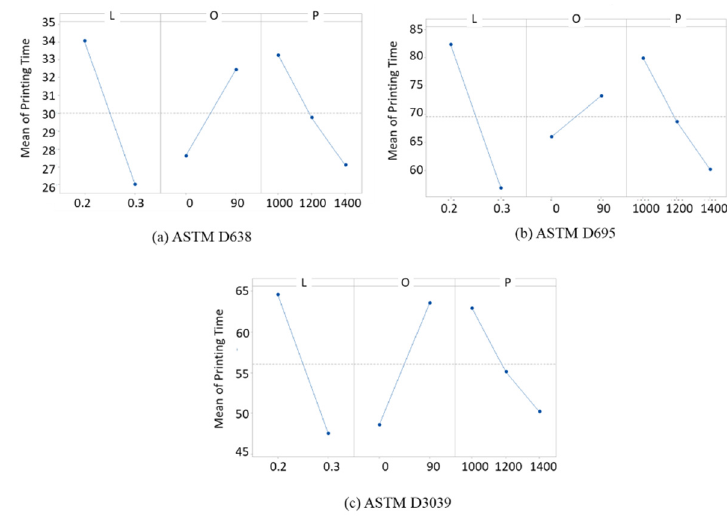
Figure 5. Main effect plots of the significant factors for printing time. ( a ) ASTM D638; ( b ) ASTM D695; ( c ) ASTM D3039. Table 6. ANOVA results for the printing time (* α < 0.05).